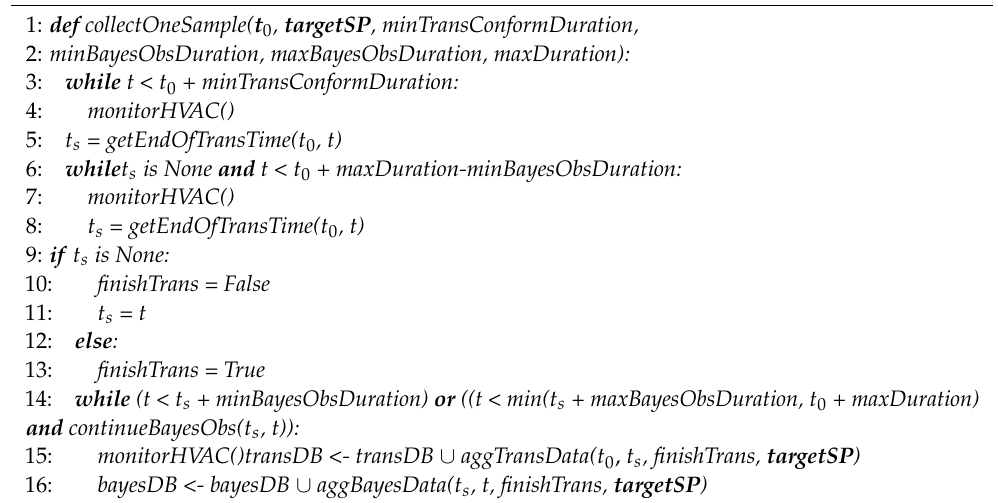
Algorithm 2: Pseudocode of construct for one Bayesian optimization sample from the raw time series monitor